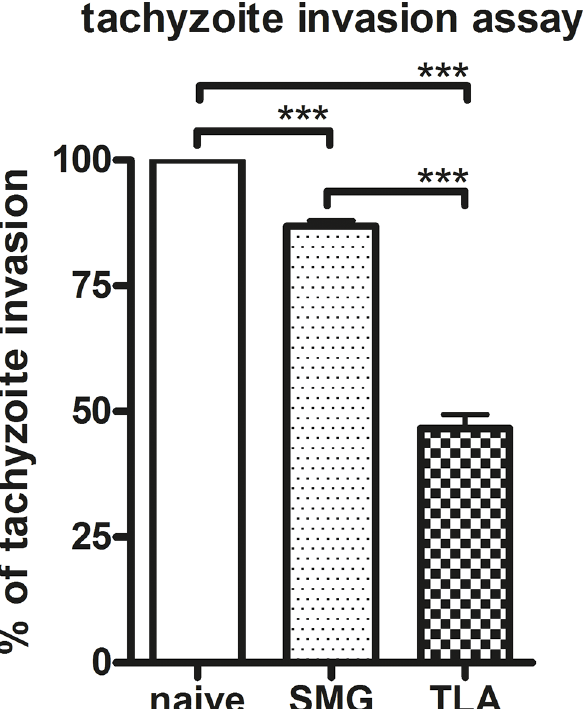
Fig 5. Tachyzoite invasion and replication assay. Tachyzoites were pre-incubated with sera from na ï ve mice collected on day 0, or with sera collected from SMG-vaccinated or TLA-vaccinated and orally boosted mice on day 34 (i.e. prior to infection). Bars represent mean percentage of reduced tachyzoite invasion and replication of Vero cells after incubation. In vitro assays were performed with pooled serum samples (n = 5) repeated three times. Results represent data of three independent experiments. Data are expressed as mean ± SEM. *** p <